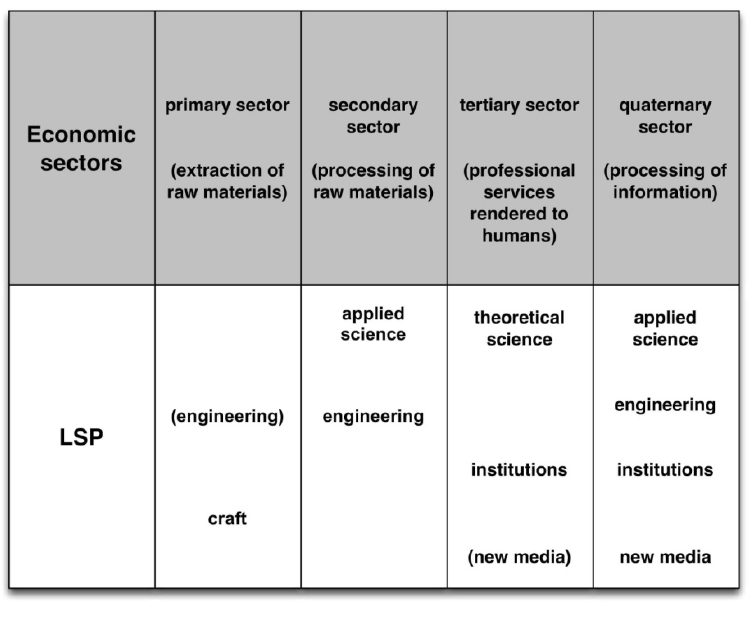
Fig. 2: LSP horizontal structuring (translated from Roelcke 2014:159) Structuring LSP based on economic sectors was already proposed by Möhn and Pelka (Möhn & Pelka 1984:35), albeit with only three sectors, i.e. primary production, manufacturing and service. Roelcke differentiates between four sectors, the first: extraction of raw materials, the second, the processing of raw materials, the third: professional services rendered to humans, and the fourth: the processing of information, and assumes that all areas of human activity can be described with this model (Roelcke 2014:158f.). Applied sciences, institutions, engineering and new media are assigned to more than one sector – this serves as an illustration of this structuring. Roelcke further suggests this model be the basis for a horizontal typology of German LSP and adds that his typology does not give any information about the features specific to each LSP itself